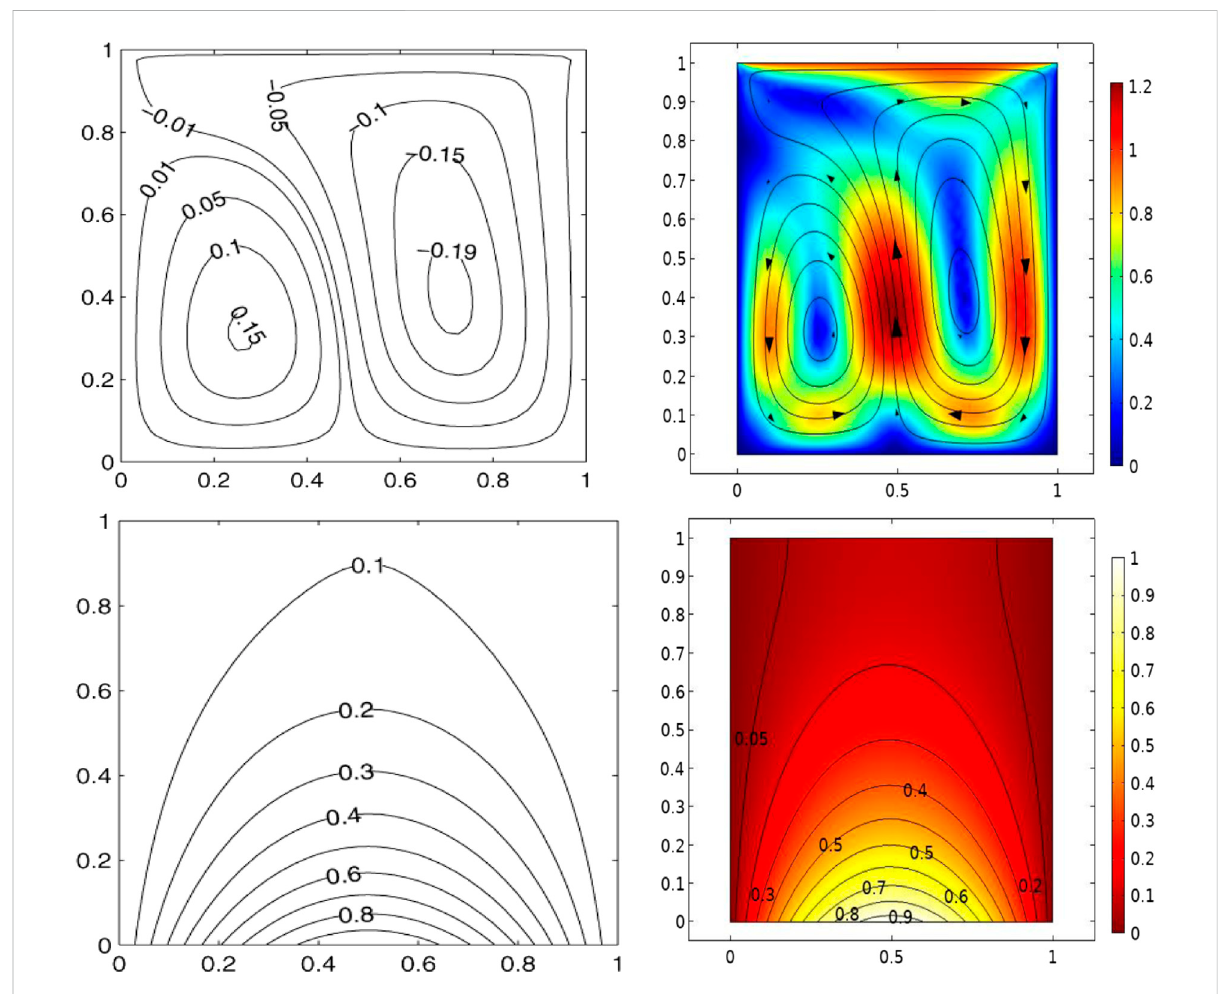
FIGURE 4 Comparison of results with the outcome published by Basak et al.